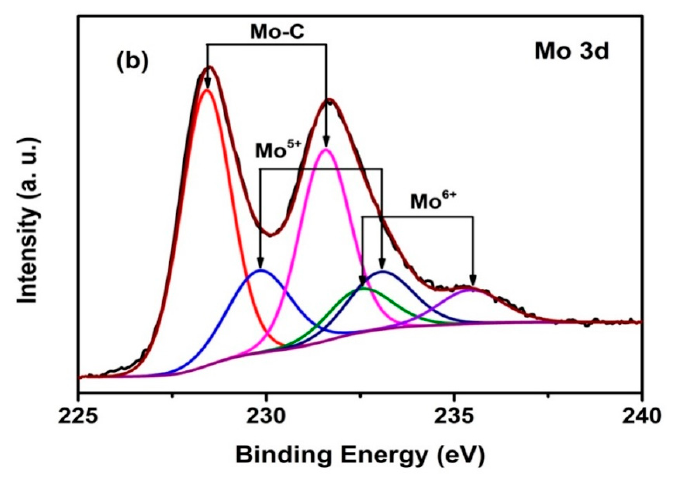
Figure 4. Curve-fitted Mo 3d core level spectra of Mo-DLC coatings: ( a ) 3.9 at.% Mo and ( b ) 16.2 at.% Mo.